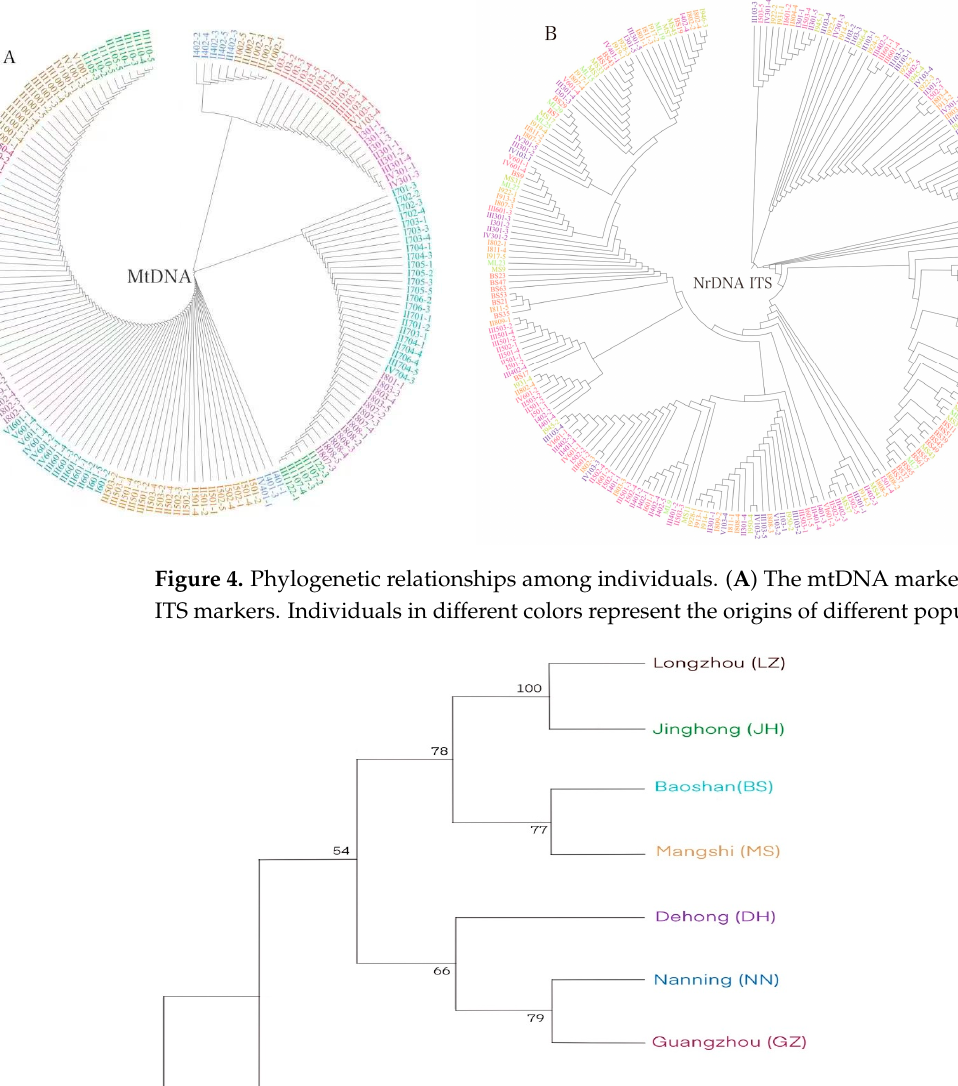
Figure 3. Effects of isolation by distance (IBD) on population genetic differentiation. ( A ) Pearson correlation between 𝐹 (cid:3046)(cid:3047) and geographic distance for the mtDNA markers. ( B ) The regression anal- ysis of 𝐹 (cid:3046)(cid:3047) /(1 − 𝐹 (cid:3046)(cid:3047) ) on geographic distance for the nrDNA ITS markers.